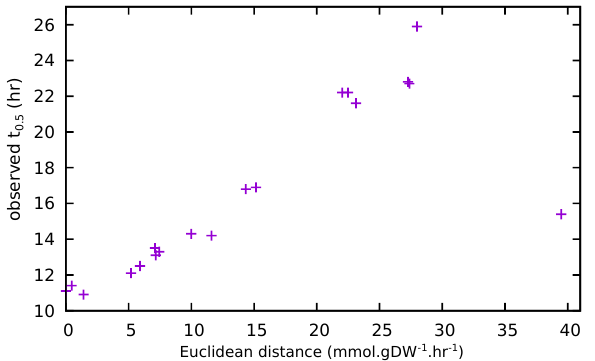
Figure 4. Comparison of calculated impacts of the removal of single amino acids (Euclidean distance) in the model and experimentally observed impacts ( t 0.5 ). The outlying point at the lower right of the figure represents the -PRO